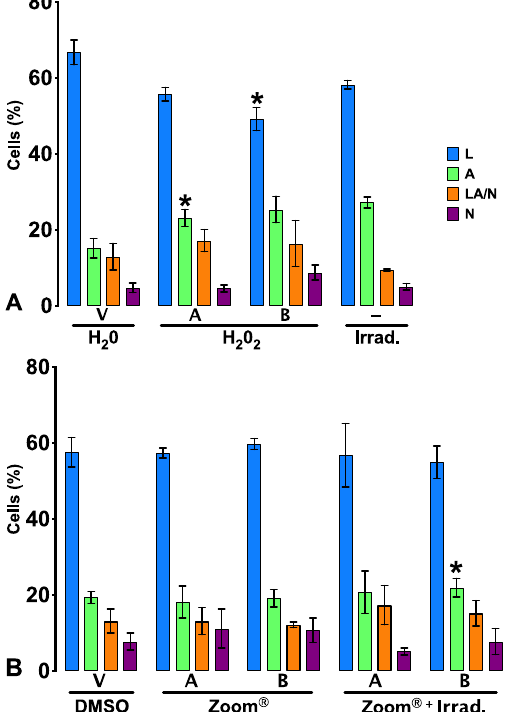
Figure 2. Cell viability determined by flow cytometry using the annexin-V / propidium iodide (AV / PI) incorporation assay. v: vehicle; – : no compound administration. Results are presented as the percentage of live cells (V), early apoptosis (A), late apoptosis / necrosis (A / N), and necrosis (N). Statistical di ff erences from the respective control are indicated by *, where * represents p < 0.05. The results express